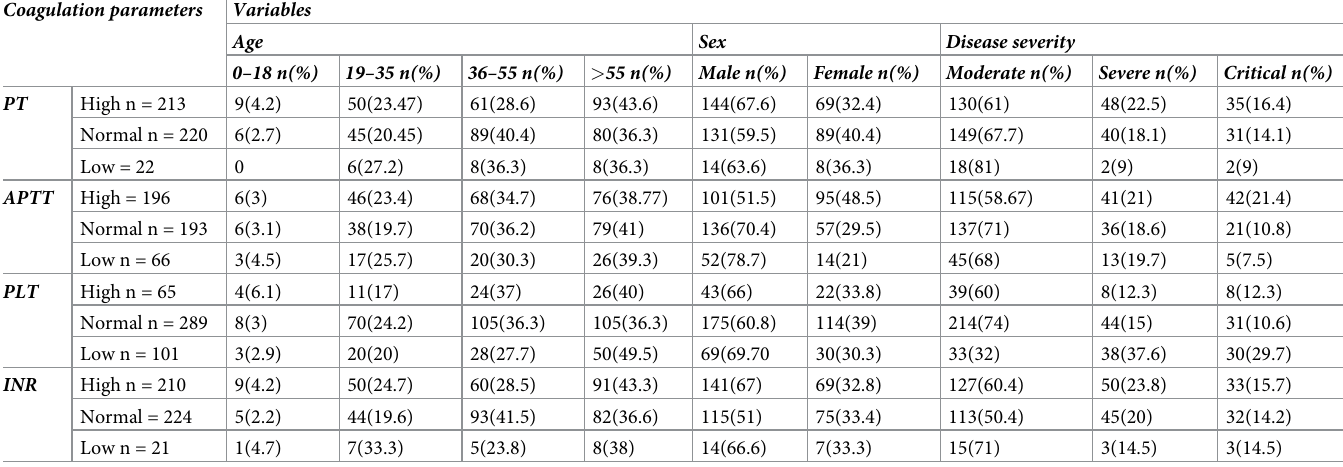
Table 3. Result of coagulation parameters in patients with severe COVID-19 according to different variables. Coagulation